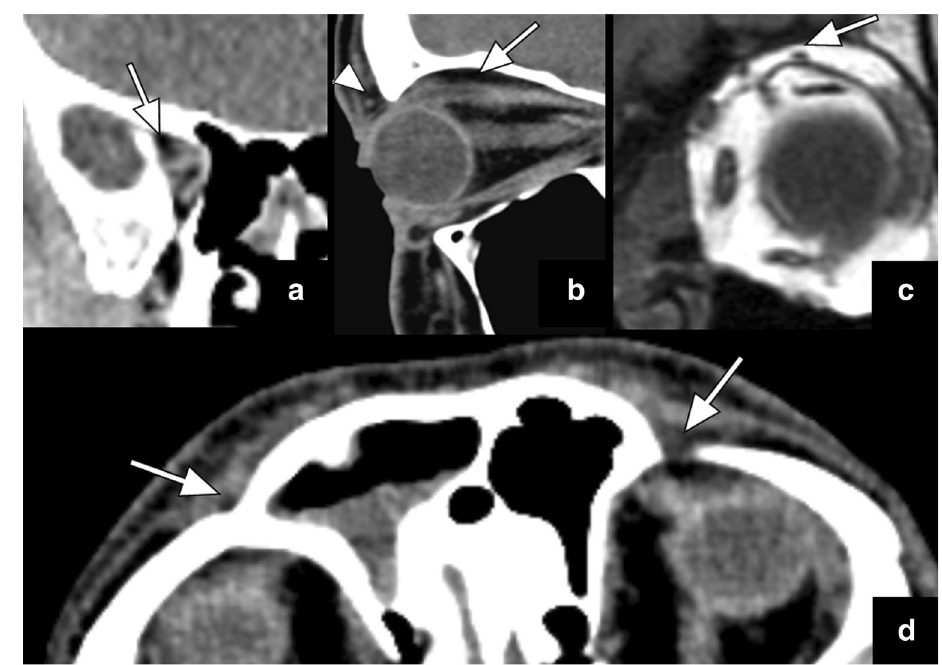
Fig. 1 Coronal ( a ) and oblique sagittal ( b ) reformatted CT images, as well as coronal ( c ) T1- weighted images illustrate the normal fat pad ( arrows ) around the ophthalmic nerve (V1) atthe orbital apex ( a ) and superior to the levator palpebrae muscle ( b – c ). Axial CT image ( d ) dem- onstrates small normal fat pads anterior to the superior orbital rim ( arrows ) which can be also well- appreciated on ( b ) the oblique